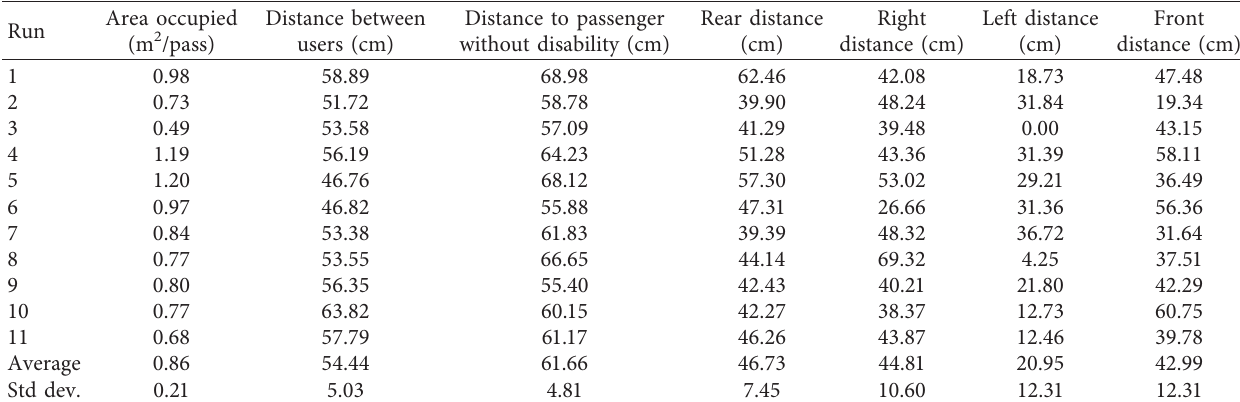
Figure 10: Graphical representation of space (measured in cm) occupied by a wheelchair user in the case of 4.0 passengers/m 2 (11 runs). Table 5: Results of the variables for the 4passengers/m 2 scenario in passenger without